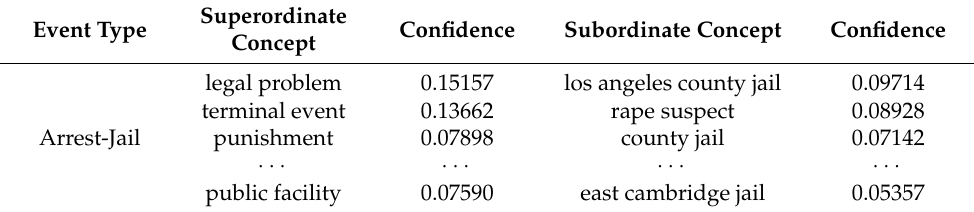
Table 1. Hierarchical concept and confidence for an example of “Arrest-Jail”; due to space constraints, we only display part of the hierarchical